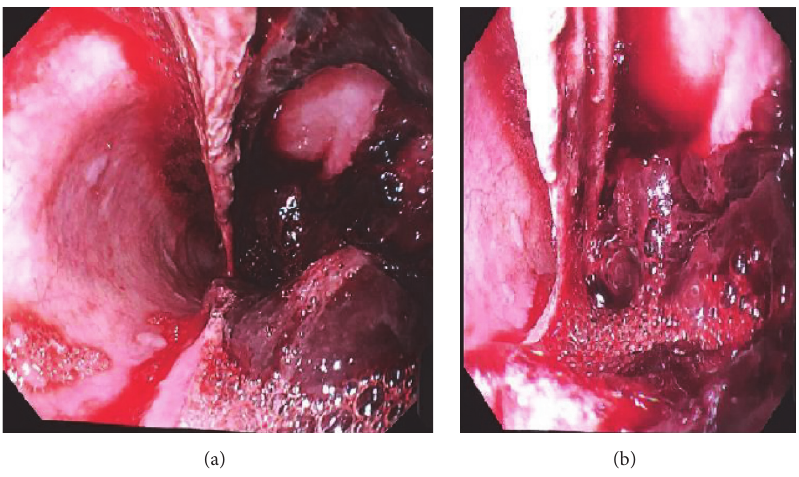
Figure 2: Endoscopic view of intramural oesophageal haematoma projecting into the